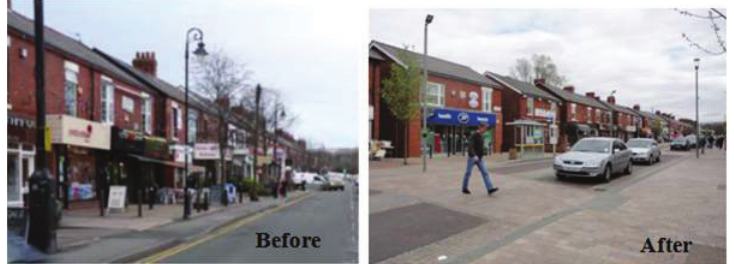
Figure 2. Changes made to Park Lane (www.hamilton-baillie.co.uk)